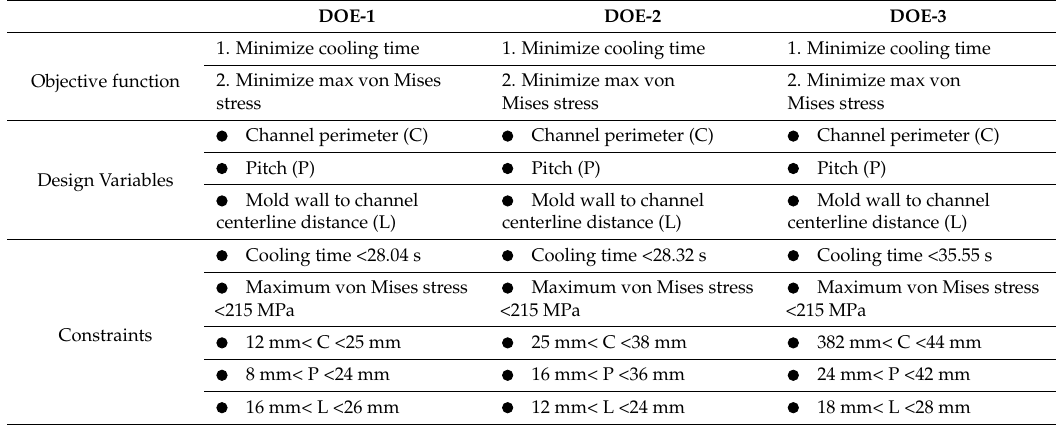
Table 3. Optimization problem statements for DOE-1, DOE-2, and